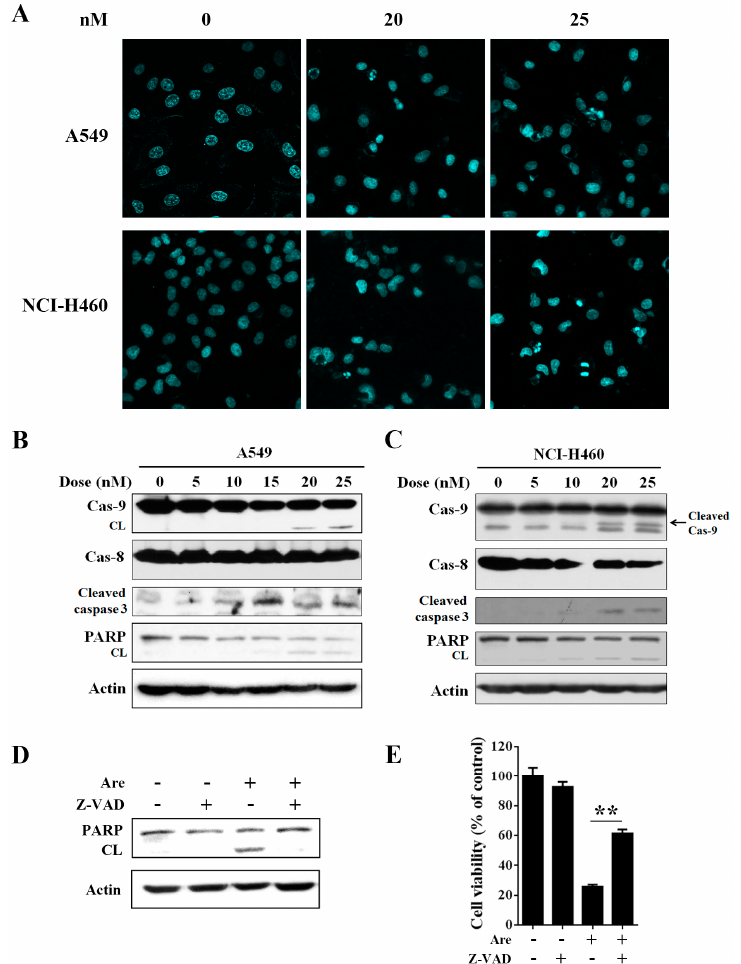
Figure 2. Arenobufagin induces caspase-dependent apoptosis in non-small-cell lung cancer (NSCLC) cells. ( A ) A549 and NCI-H460 cells were treated with the indicated concentrations of arenobufagin for 24 h, and apoptotic morphological changes were evaluated by Hoechst 33258 staining; ( B , C ) A549 and NCI-H460 cells were treated with arenobufagin at the indicated concentrations for 24 h, and protein extracts were subjected to Western blot assay with indicated antibodies; ( D , E ) A549 cells were pre-treated with the caspase inhibitor Z-VAD (40 μΜ ) for 1 h, followed by incubation with arenobufagin (Are, 25 nM) for 24 h; ( D ) poly (ADP-ribose) polymerase (PARP) cleavage was analyzed by Western blotting; ( E ) The cell viability was detected via trypan blue exclusion assay. ** p < 0.01, arenobufagin-treated group versus arenobufagin and Z-VAD combination group.